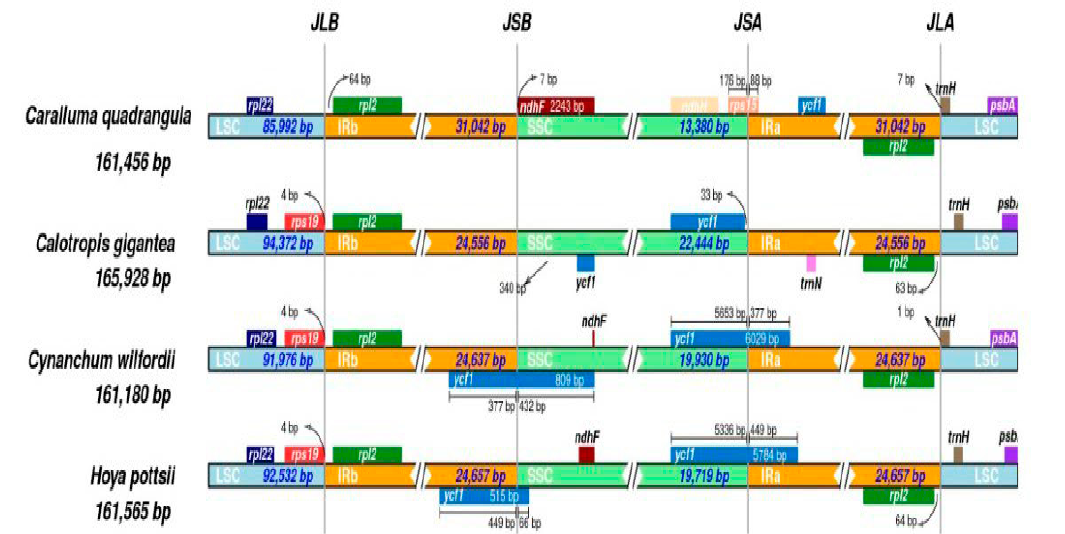
Fig. 7: Cp genome border comparison of LSC, SSC, and IR regions in the four species C. quadrangula, C. gigantea, C. wilfordii, and H, pottsii. Gene fea- tures are shown, as well as the distance between respective genes and the border points in H. pottsii and C. wilfordii. IRb and SSC borders extend into ycf1 while, in C. quadrangula, it does not extend. The number of base pairs in the border of trnH varied in C. quadrangula (6bp) while, in the genomes of C. gigantea, H. pottsii, and C. wilfordii, one base pair was observed.